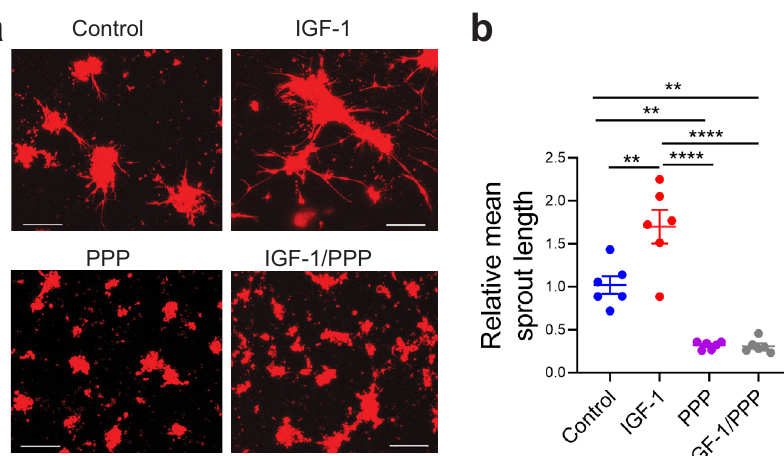
Fig. 4 Neonatal intestinal macrophages promote endothelial cell sprouting in vitro via IGF-1. a , b 4 × 10 4 mT/mG neonatal intestinal endothelial cells were co-cultured with 2 × 10 4 CX3CR1 + WT neonatal intestinal macrophages for 4 days on Matrigel in IGF-1-free media (control) or in media containing IGF-1, the IGF-1 inhibitor PPP or both. a Representative images. b Graph represents mean sprout length per well relative to control. Data are the results of three separate experiments combined. n = 6 wells/group, each dot indicates the average length of 5 – 9 sprouts from a single culture well. P values were calculated using one-way ANOVA followed by Turkey – Kramer multiple-comparison test. ** p < 0.01, **** p < 0.0001. Source data are provided as a Source Data fi